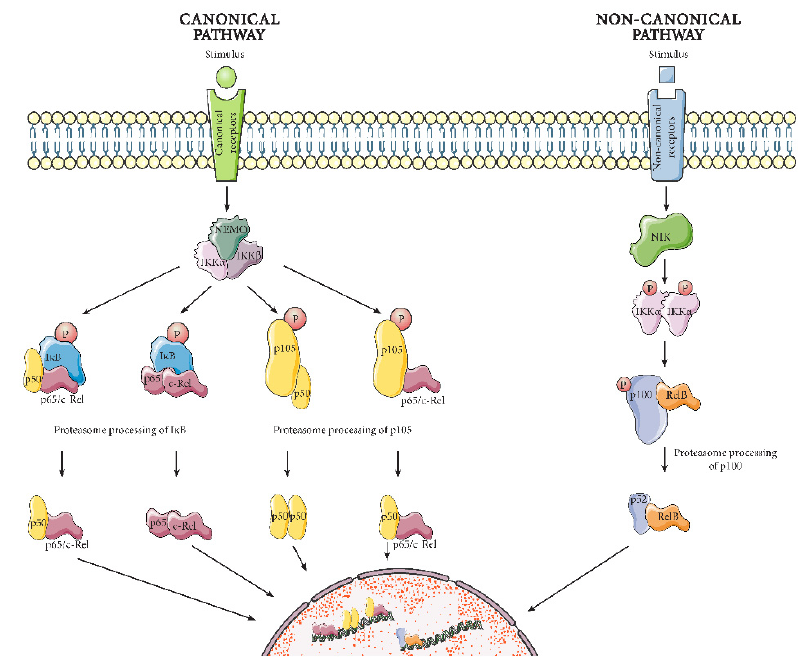
Figure 1. Simplified illustration of the canonical and non-canonical versions of the NF- κ B pathway. When a stimulus activates a canonical pathway receptor, the I κ B kinase (IKK) complex forms. The IKK complex phosphorylates the inhibitory I κ B protein and the p50 precursor protein p105, inducing their degradation and processing, and enabling the translocation of the NF- κ B dimers into the nucleus for gene expression regulation. Upon activation of the non-canonical pathway, NF- κ B-inducing kinase (NIK) activates the IKK α dimer, leading to phosphorylation and proteasome processing of p100. This results in production of p52, which together with RelB translocates to the nucleus and regulates transcription. The dimers presented in this figure are not the only possible combinations.